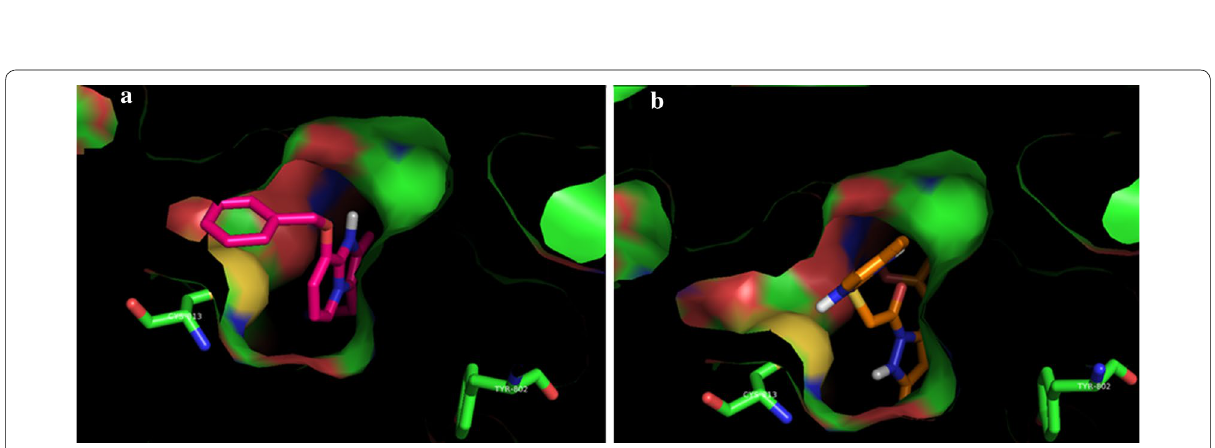
Fig. 4 SCH28080 covering the Cys813 in the active site ( a ). Compound 5d covering the Cys 813 in the active site ( b